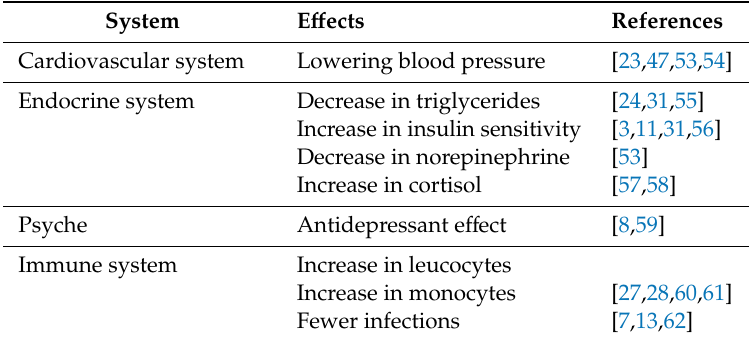
Table 1. Benefits of cold-water